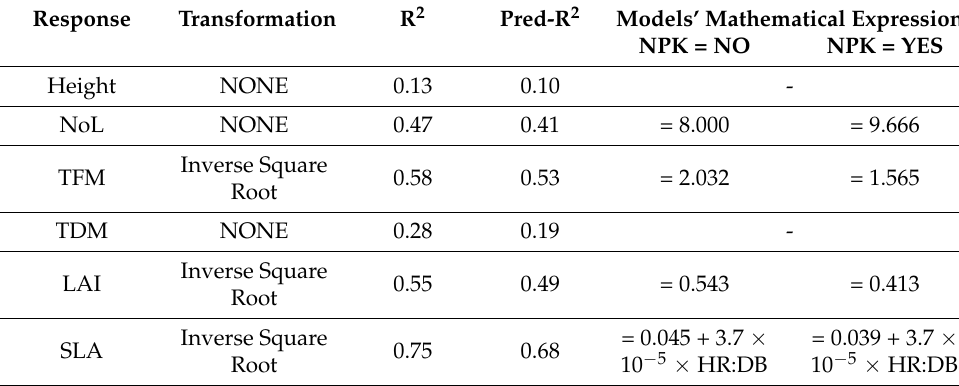
Table 6. ANOVA results.